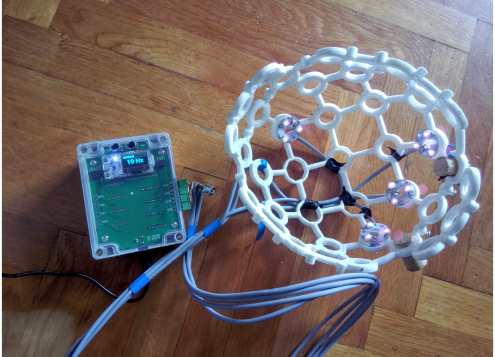
Figure 3. The cluster of IR LEDs mounted on a 3D -printed holder (headset) [34] and a prototype produced. One cluster of IR LEDs is located between P3/P7, another between P4/P8, and two more clusters are located above electrodes Fz and